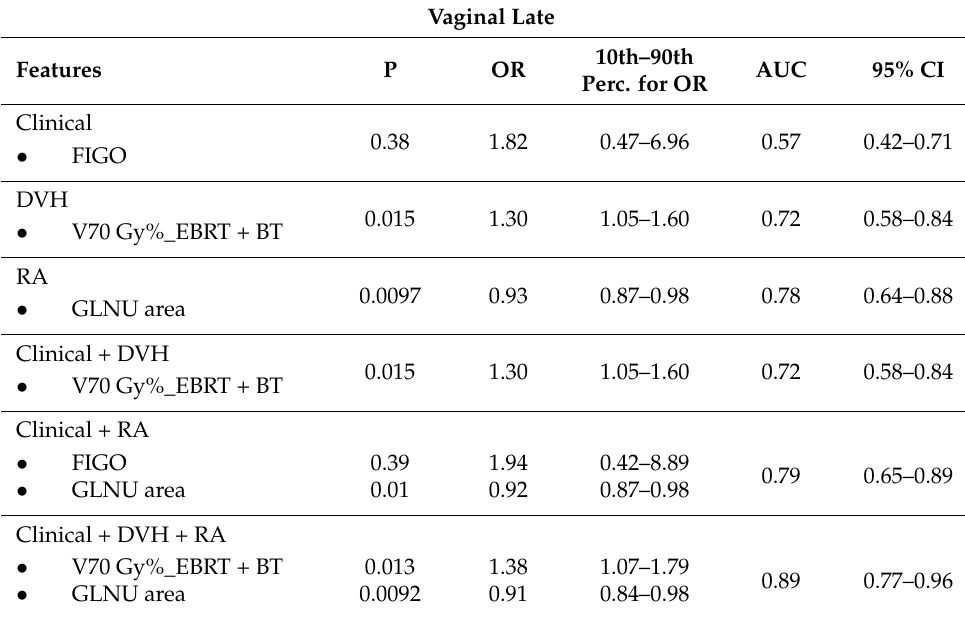
Table 6. Results of the multivariate logistic analysis for late vaginal